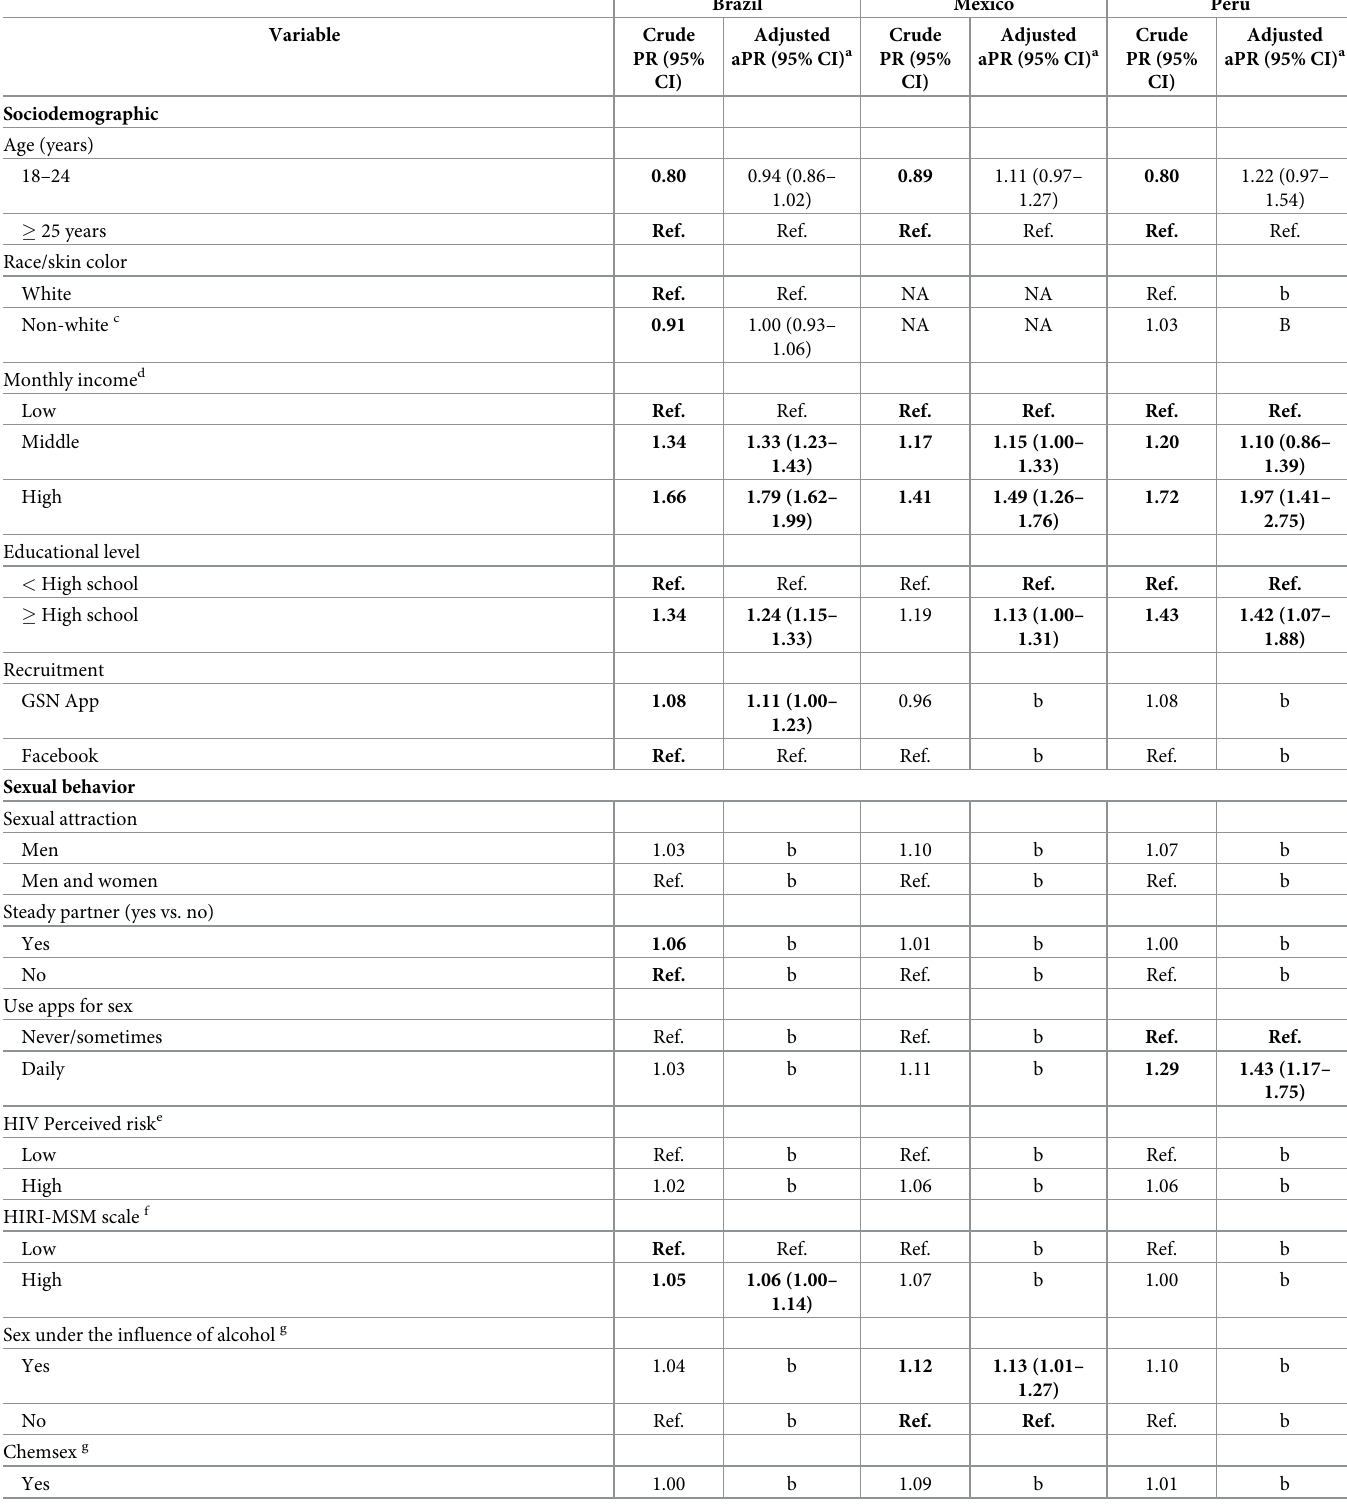
Table 3. Factors associated with willingness to use HIVST among MSM from Brazil, Mexico, and Peru,